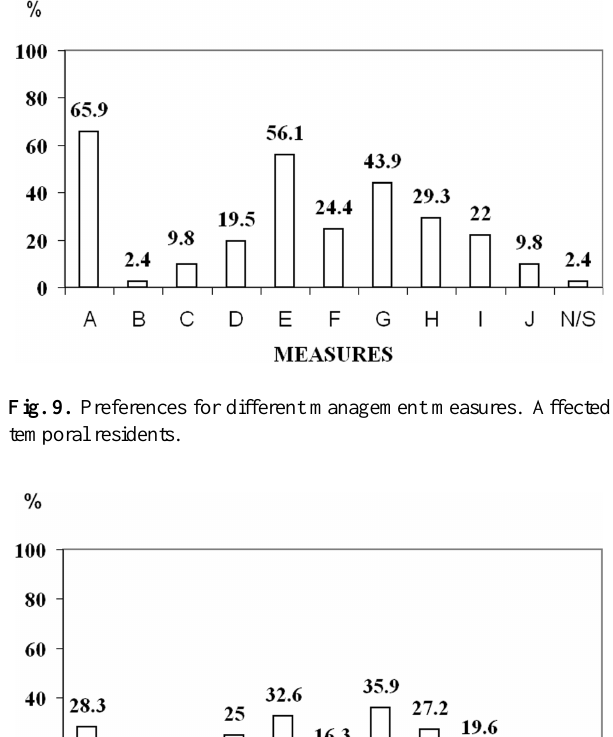
Fig. 12. Preferences for flood management options. Mayors and local